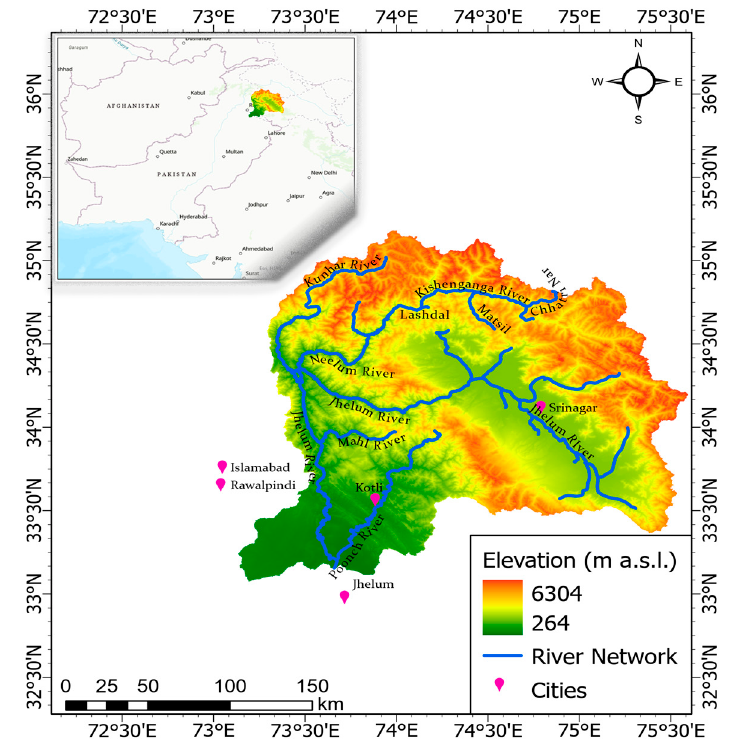
Figure 1. Location of the study area.